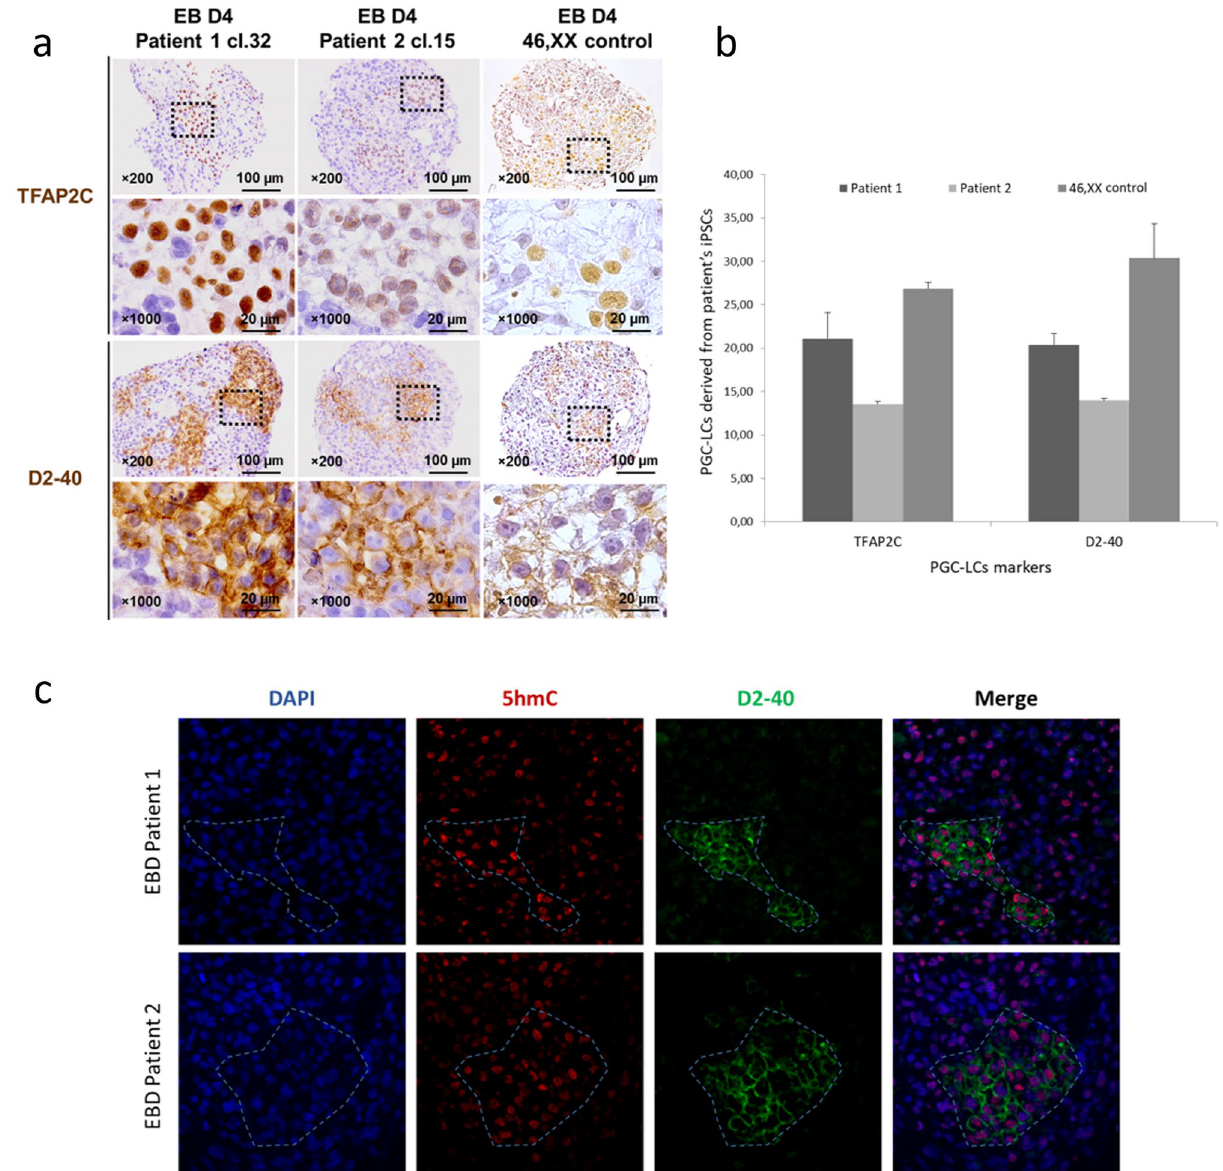
Figure 4. Immunohistochemical (IHC) expression of TFAP2C and D2-40 on EBs sections. The full protocol was repeated three times for the iPSCs of patient 1 and two times for the iPSCs of patient 2. ( a ) IHC pictures showing PGC-LCs positive for TFAP2C and D2-40 in EB D4 from patient 1 cl.32-hiPSCs and patient 2 cl.15- hiPSCs. ( b ) Percentage rate of PGC-LCs cells population differentiated within EBs from patient 1 cl.32-hiPSCs and patient 2 cl.15-hiPSCs as estimated after quantification. ( c ) Immunofluorescence (IF) showing localization of DAPI (blue), D2–40 (green) and 5-hydroxymethylcytosine (5hmC, red) in PGC-LCs and somatic cells in EBs at day 4. In order to clearly show the localization of PGC-LCs, we used the specific germ cell membranous marker D2-40 in combination with 5hmC for IF assay. Images show that, 5hmC is detectable in PGC-LCs in higher levels than in in somatic